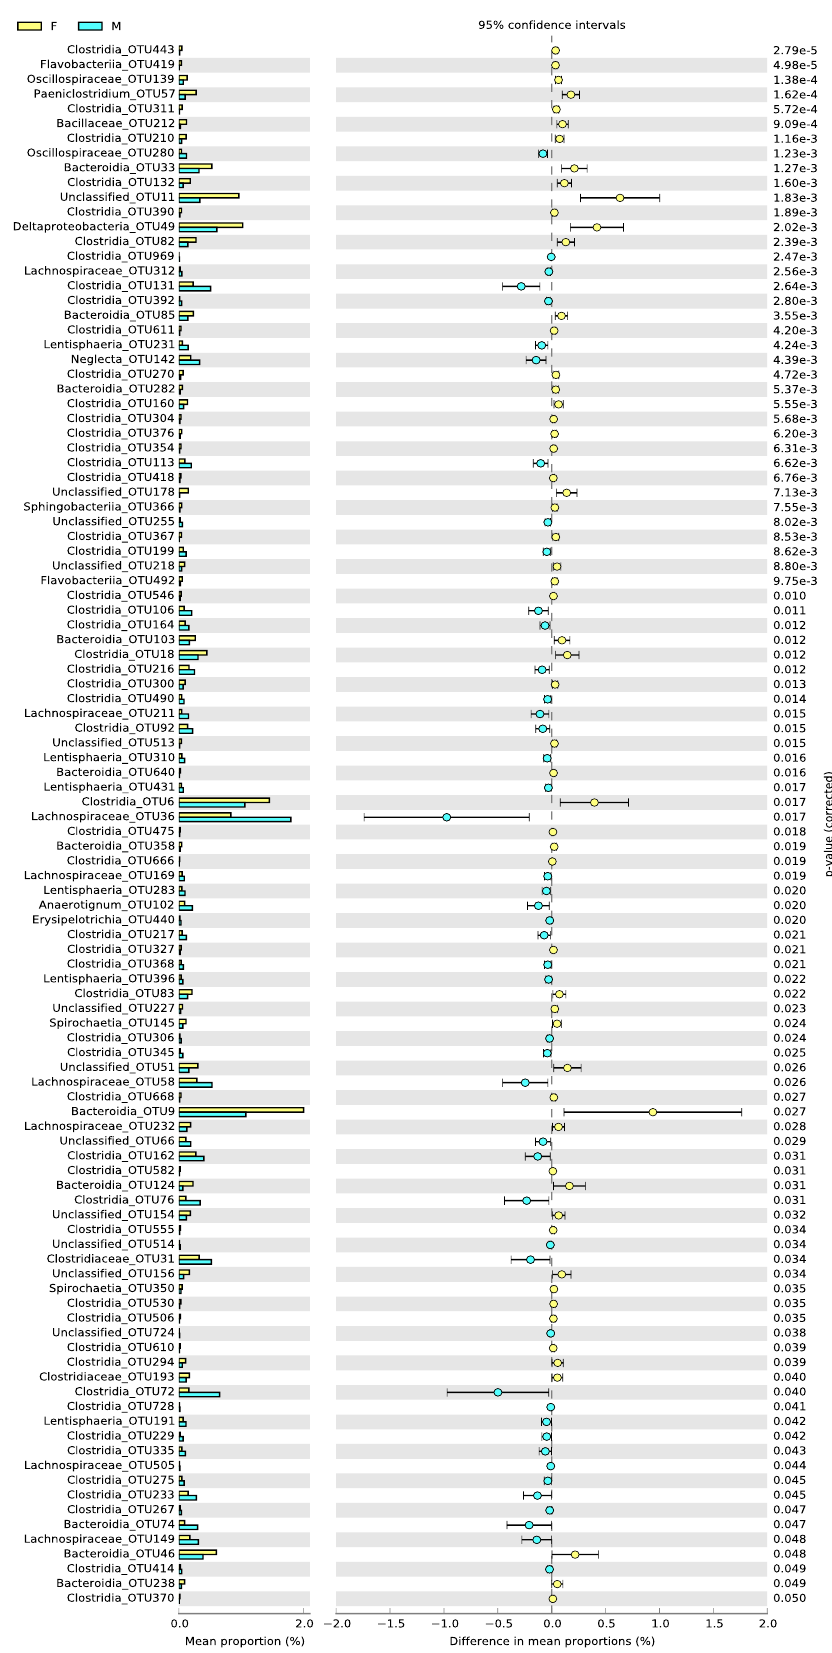
Figure 2. Extended error bar plot indicating the significant differences in mean abundance of OTUs between males and females.